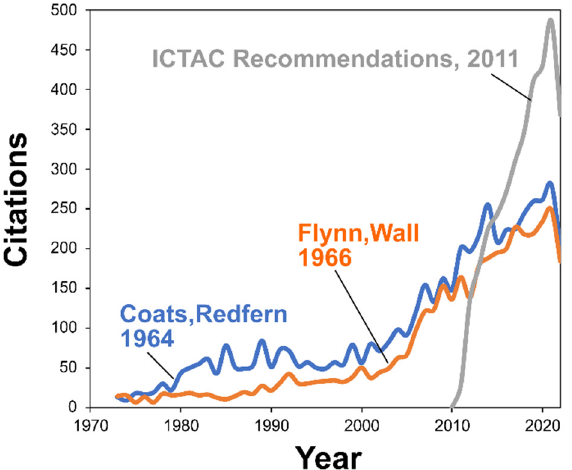
Figure 7. The rise of citations of original publications reporting the corresponding kinetic methods by Coats and Redfern [62] and Flynn and Wall [31,90] and ICTAC Kinetic committee recommendations for performing the kinetic analysis [12] (Dimensions database data).